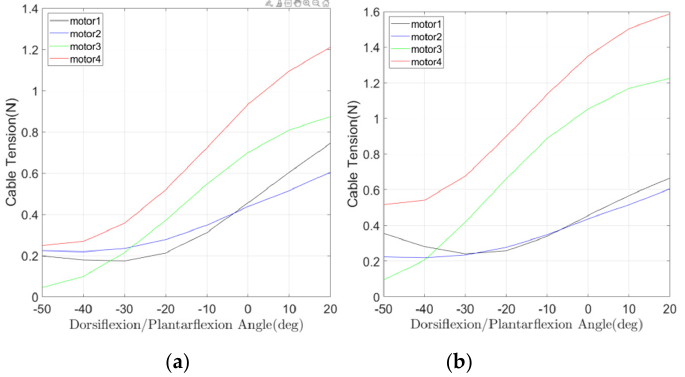
Figure 7. Computed cable tensions during a simulated controlled operation: ( a ) in passive mode and ( b ) in active resistive mode.